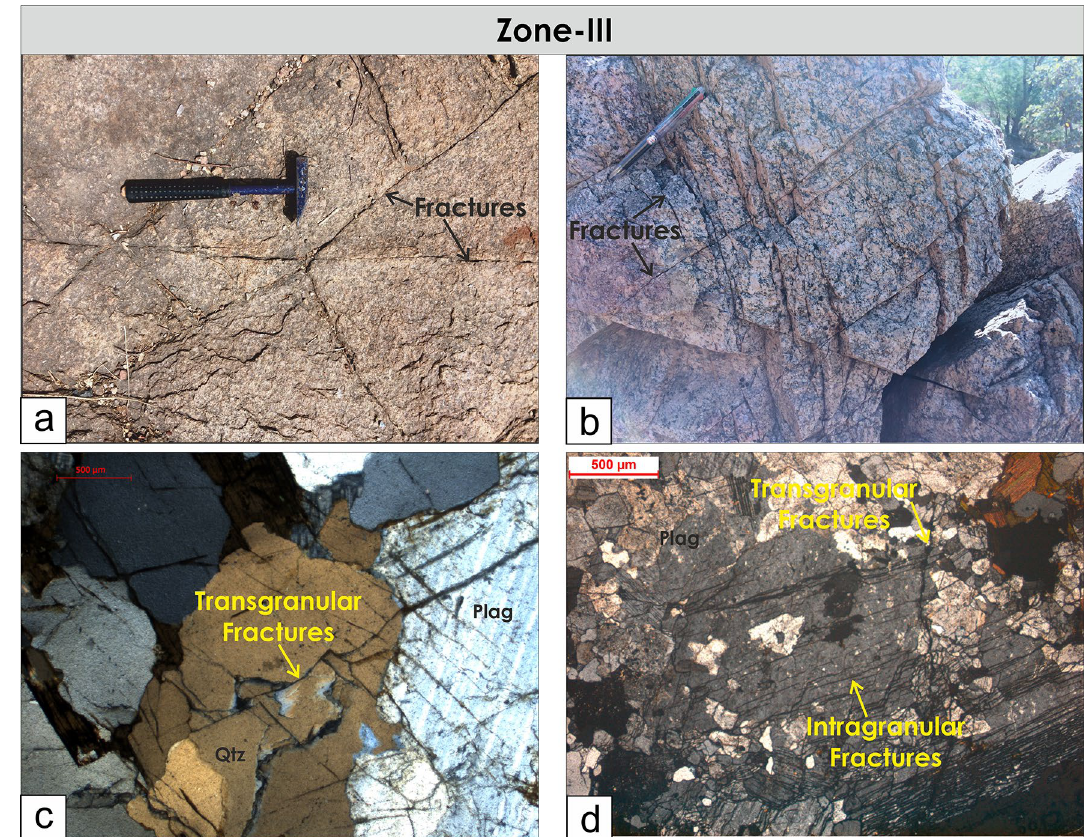
Figure 8. Field photographs and photomicrographs of rocks and structures from Zone-III. ( a,b ) Brittle fractures and faults overprint the massive granites. ( c,d ) Both intragranular and transgranular microfractures observed under the